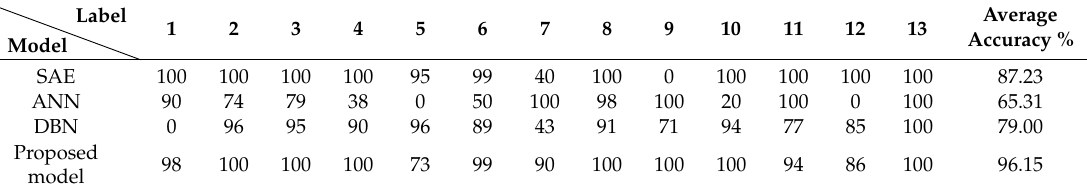
Table 6. Comparison of testing results of dataset2 under load 1 kN by di ff erent models.